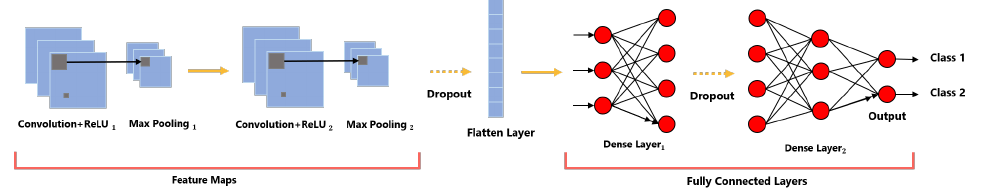
Figure 8. CNN architecture showing the structures of the two Rectified Linear Unit (ReLU) activated convolutional layers and that of the fully connected layers having two dense